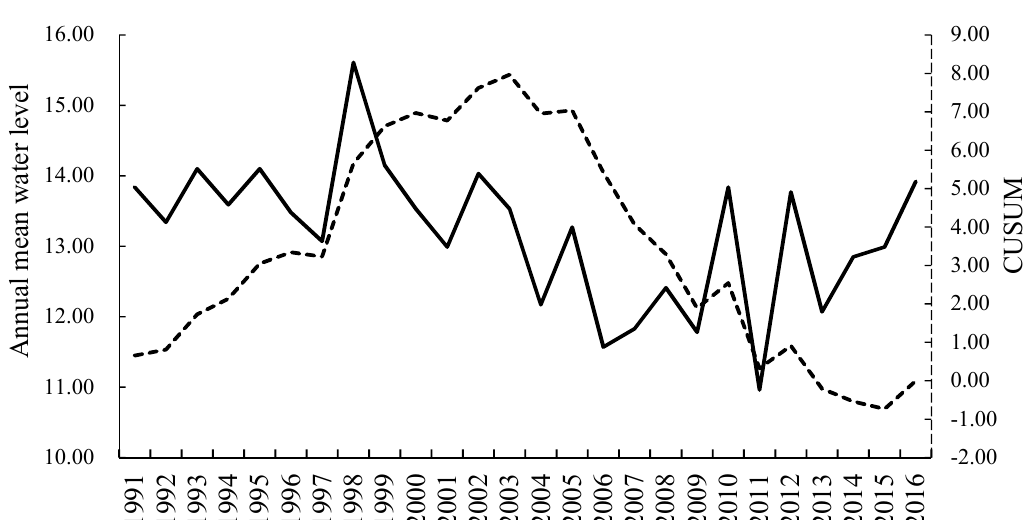
Figure 3. Annual mean water level and combination of cumulative sum charts (CUSUM) for 1991–2016. (The solid line is the annual mean water level, and the dashed line is the CUSUM of corresponding parameters.).